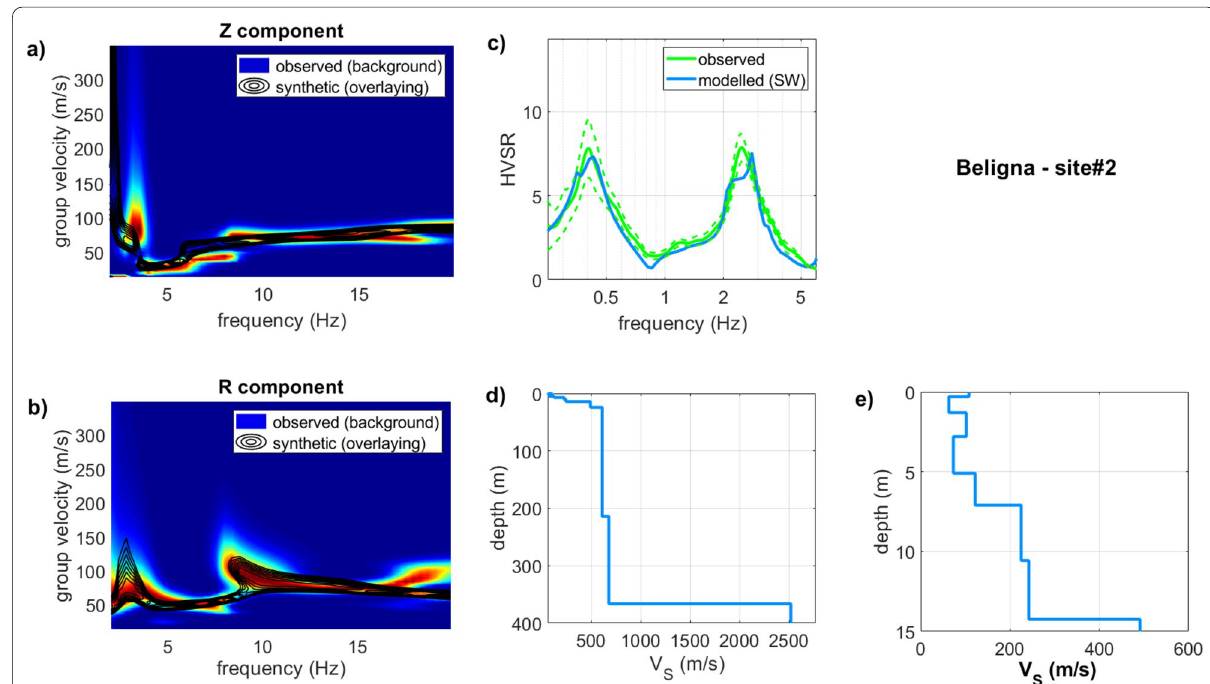
Fig. 15 Beligna#1—western area (HS2): same data as for Fig. 13 (HS1). The HVSR peak at about 2.5 Hz (not present at site#1) is due to the presence of superficial very soft (peat-like) sediments